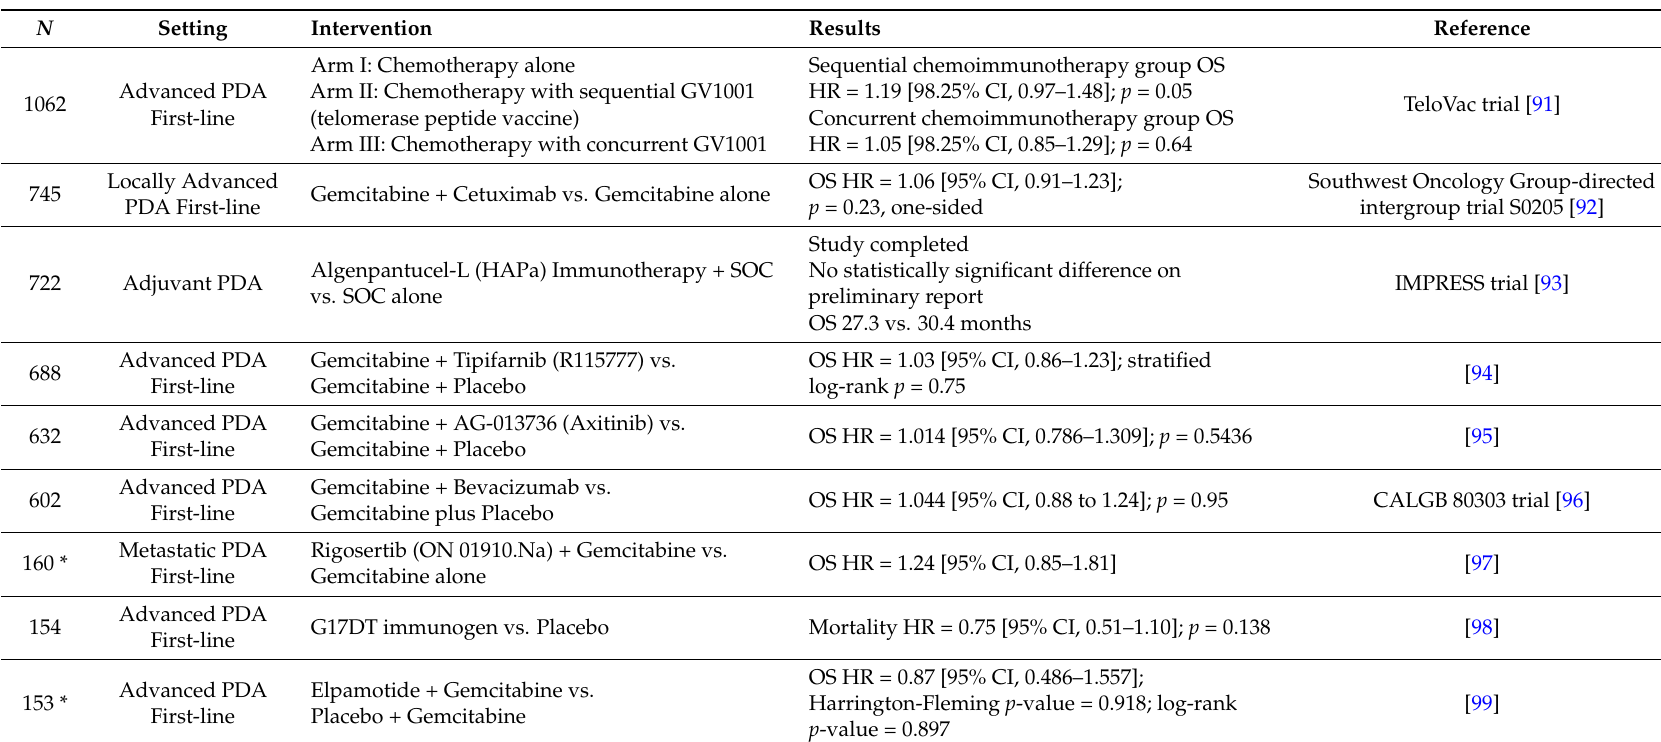
Table 4. Completed Phase III RCTs on targeted drugs for pancreatic ductal